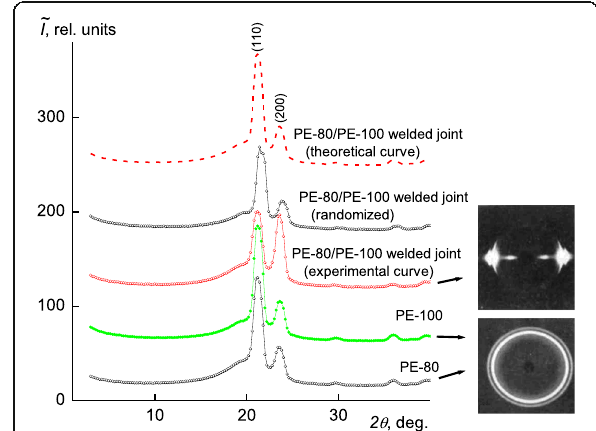
Fig. 3 WAXS diffraction patterns of PE-80, PE-100, and of PE-80/PE- 100 welded joint ( experimental curve ), PE-80/PE-100 (randomized), PE-80/PE-100 ( theoretical curve